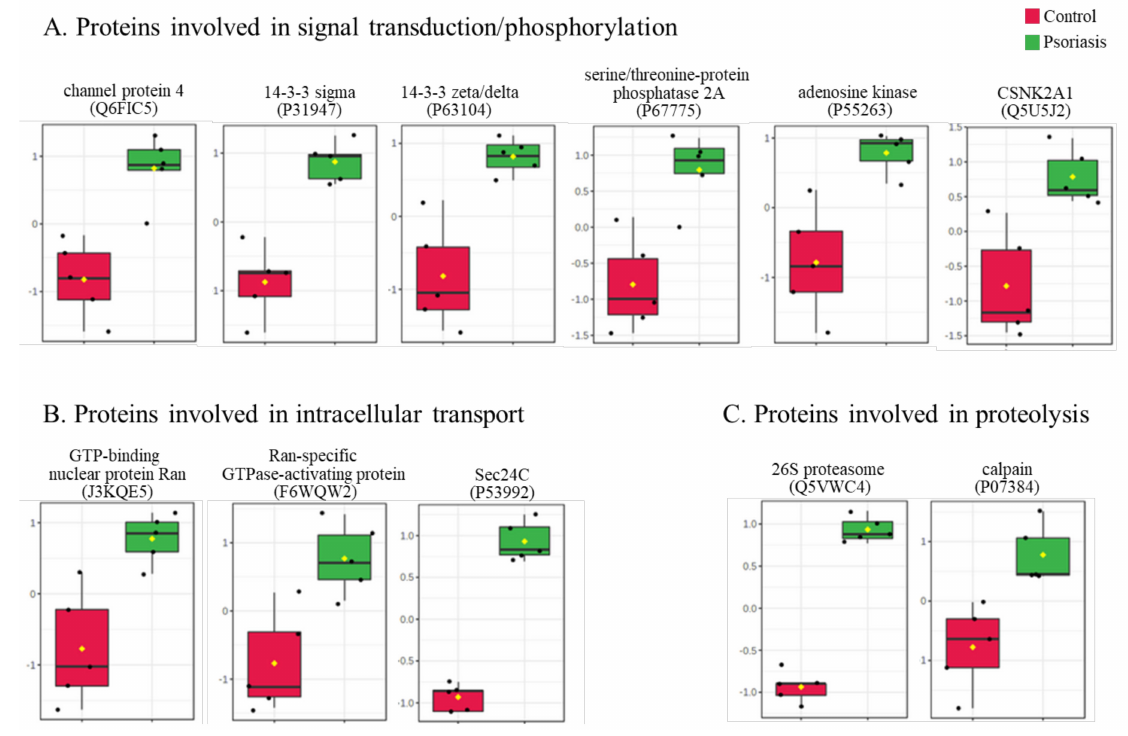
Figure 6. The level of significantly changed proteins involved in signal transduction / phosphorylation ( A ), intracellular transport ( B ) and proteolysis ( C ) of fibroblasts isolated from the skin of psoriatic patients ( n = 5) and healthy controls ( n =